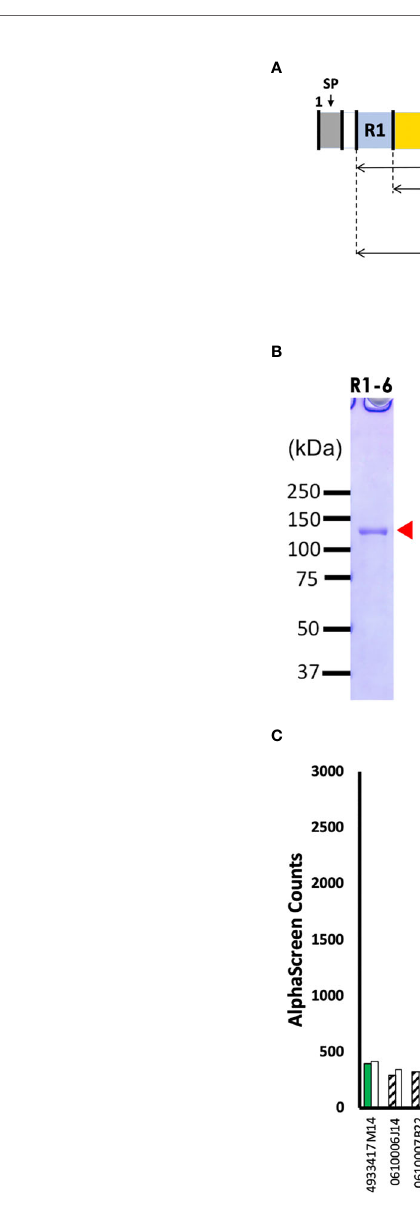
FIGURE 1 | PyEBL interacts with basigin, a mouse erythrocyte surface protein. (A) Schematic representation of PyEBL (PY17X_1337400) domain architecture. The protein has a predicted signal peptide (SP; 1 to 22 aa), followed by 7 homology regions (R) 1-7. R2 is referred to as the Duffy binding-like domain; R6 is the C-terminal Cysteine-rich domain. Recombinant PyEBL R1-6 amino acids V 28 -N 788 as well as truncates corresponding to R1-2, amino acid V 28 -G 437 ; R2, E 113 -G 437 ; R3-5, G 437 -C 717 ; and R6, C 717 -N 788 were expressed as N-terminal GST-tagged proteins by wheat germ cell-free system (WGCFS). (B) WGCFS expressed recombinant PyEBL R1-6 was puri fi ed by glutathione-Sepharose 4B column and resolved by 12.5% SDS-PAGE under reducing condition and stained with Coomassie brilliant blue (CBB). The protein resolved as a single band as shown (arrowhead) at the expected molecular weight. All blue ™ molecular marker points are shown. (C) AlphaScreen reactivity pro fi le of recombinant PyEBL R1-6 and mono- biotinylated recombinant putative mouse erythrocyte surface proteins. PyEBL R1-6 was mixed with mouse anti- PyEBL R1-6 polyclonal antibodies, 1 m l P. yoelli parasite lysate and each of the 237 biotinylated erythrocyte surface proteins and incubated for 1h at 26°C to form an antibody-native PyEBL-mouse protein complex. A suspension of streptavidin- coated donor-beads and protein G conjugated acceptor-beads mixture was then added to the reaction followed by a 1 h at 26°C incubation. This allowed the donor- and acceptor-beads to optimally bind to biotin and rabbit IgG, respectively. Upon illumination of this complex, a luminescence signal at 620 nm was detected by the EnVision plate reader (PerkinElmer) and the result was expressed as AlphaScreen counts (ASC). The top 23 mouse proteins were assayed two times which are represented by a white and a fi lled pattern bar per protein. The number on the x-axis represent FANTOM IDs. Flotillin 2 (4933417M14) reacted with anti-Pys25 mAb#16 was used as the negative control. Basigin (ID: 0610008G13) had the highest signal. Detailed description is provided in Supplementary Table S4 . (D) Sensorgram of SPR single-cycle kinetic analysis between recombinant PyEBL R1-6 and recombinant mouse basigin. GST tagged ecto-basigin, expressed as illustrated, was immobilized on CM5 chip and used as the ligand while recombinant PyEBL R1-6 was used as analyte. His-GST was assayed as a negative control. Blue curve represents the actual data-generated sensorgram while black curve indicates line of fi t used to calculate kinetics parameters. The assay was performed at an increasing analyte concentration of 6, 12, 24, 48, and 96 nM at 120s and dissociation time of 180s. The last dissociation time was extended to 600s to accurately determine kinetic